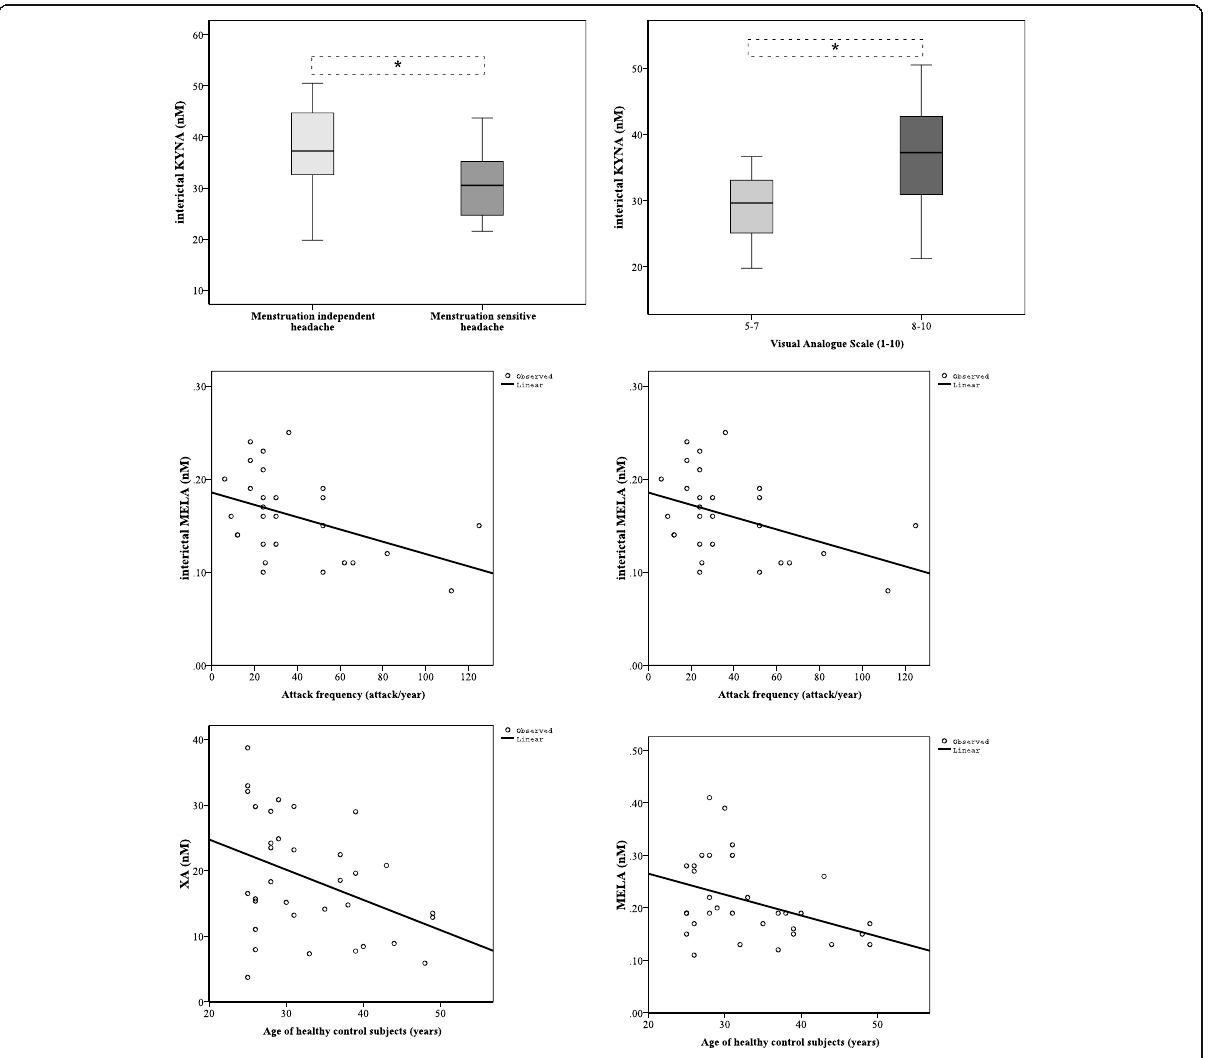
Fig. 4 Associations between metabolic changes and clinical features of MWoA patients in the interictal period, and age of healthy controls (median, interquartile range, minimum and maximum values were presented in the figures of KYNA). Sample sizes in groups: interictal phase of migraineurs without aura (n = 36); Sample size in case of MELA: healthy control (n = 30), interictal phase of migraineurs without aura (n = 28). KYNA: Kynurenic acid, XA: Xanthurenic acid, MELA: